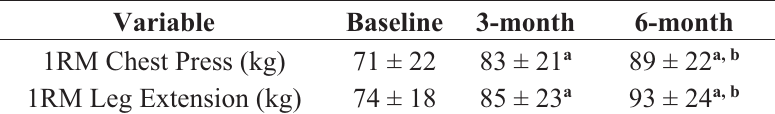
Table 3. Muscular Strength ( N =